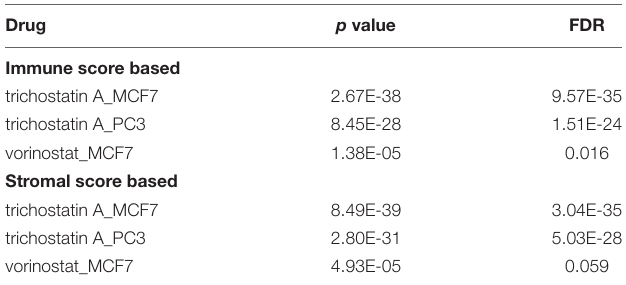
TABLE 2 | Key drugs that had potential therapeutic effects on SARC patients with lower immune or stromal scores. Drug p value